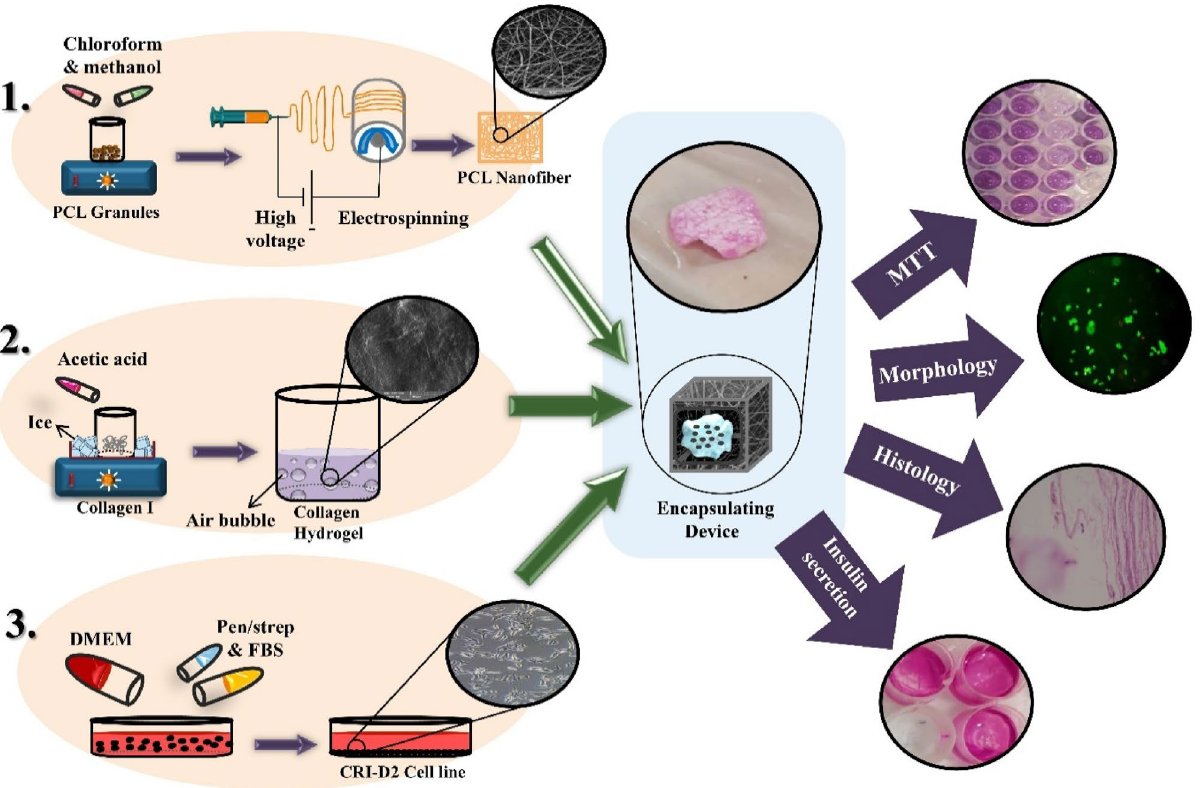
Figure 9. Collagen type I hydrogel is an acceptable scaffold and PCL nanofibrous mats have also demonstrated suitable characteristics as a membrane for β cells. therefore, cells can live and function while encapsulated in